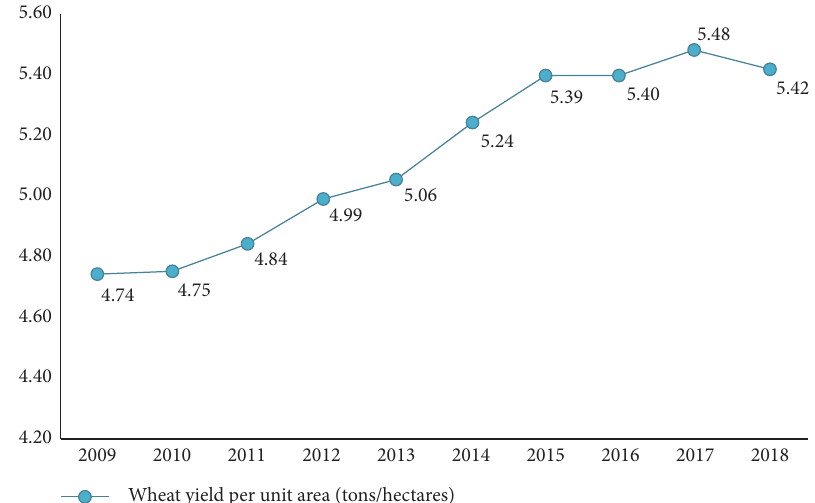
Figure 2: Wheat production per unit area in China from 2009 to 2018 (source: National Bureau of